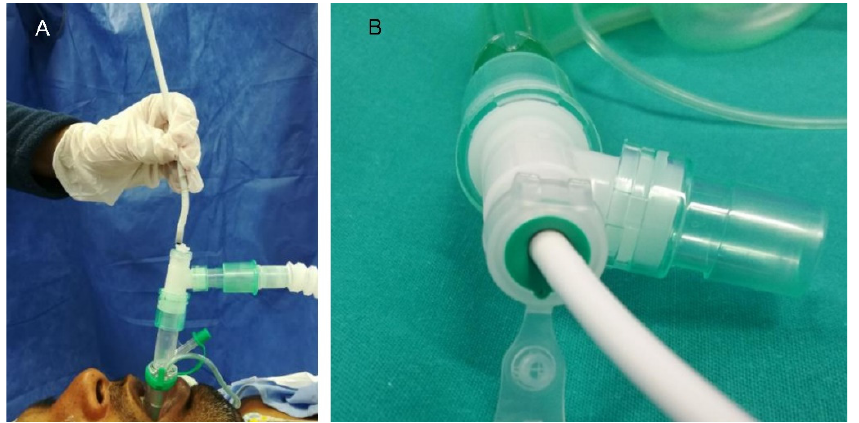
Figure 3. ( A ) Insertion of the flexible fiberscope through the ventilatory canal of the laryngeal mask for glottic visualization. ( B ) Proximal end of the laryngeal mask: T ‐ connector. T ‐ tube or connector allows for leak ‐ free ventilation during fiberscope introduction.